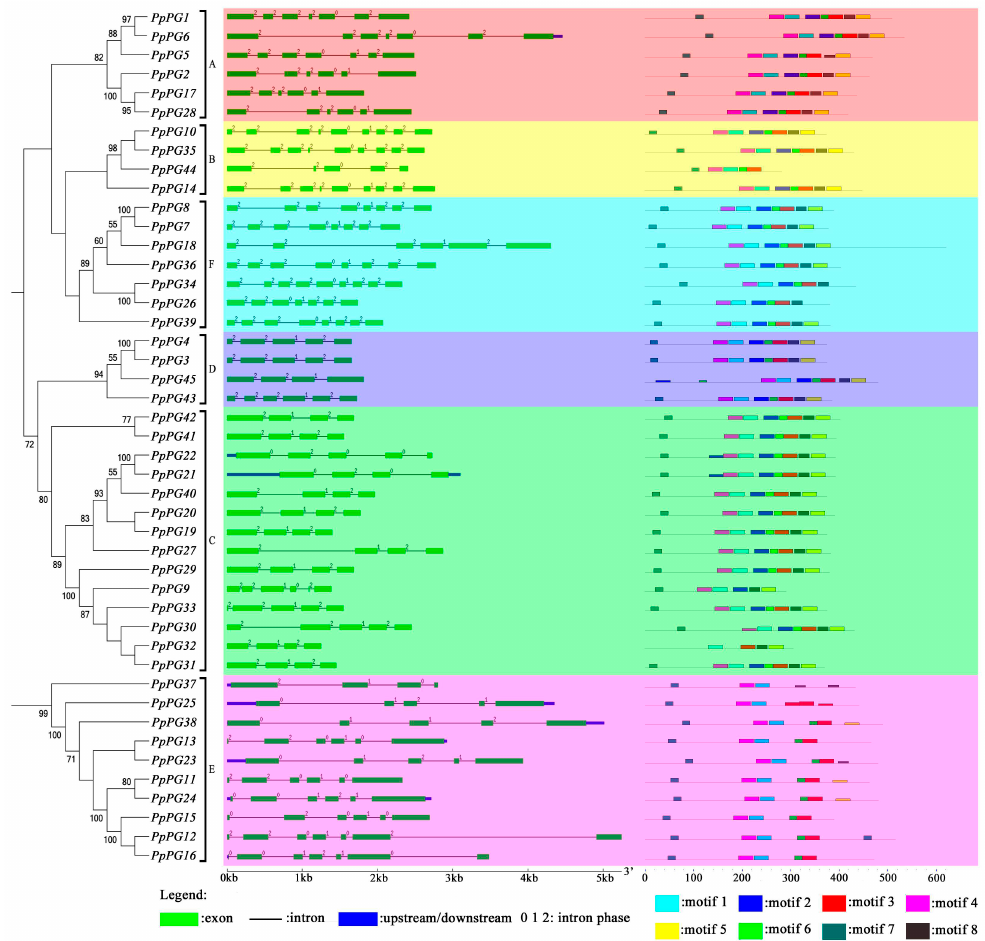
Figure 4. Phylogenetic tree, PG gene structures and conserved motif analysis in peach. The left part indicates the phylogenetic tree of PG genes in peach. Figures on branches indicate bootstrap percentage values calculated from 1000 replicates with MEGA 6.0, and values lower than 50 are hidden in the phylogenetic tree. The middle part represents intron/exon organization of PG genes, and different background colors indicate different subclasses. The right part shows the composition and position of conserved motifs of peach PG genes, with eight motifs shown in different colors.